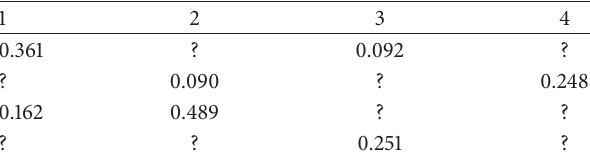
Table 1: The partly unknown TP